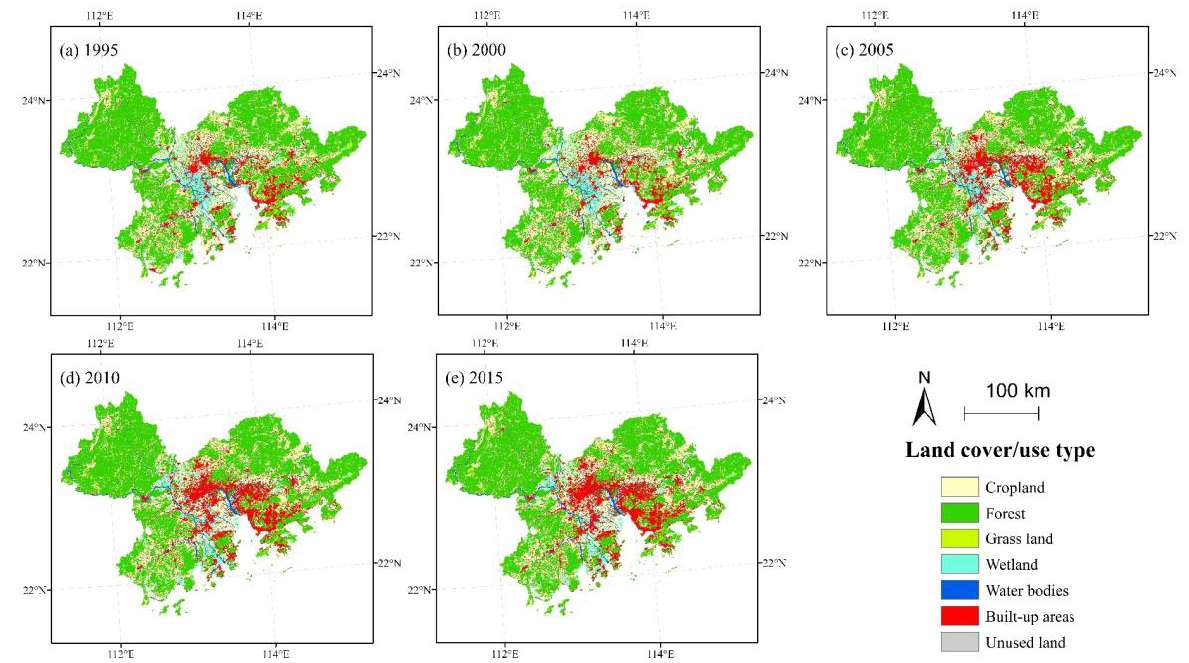
Figure 2. Land cover/use in the GBA during the period from 1995 to 2015: ( a ) 1995, ( b ) 2000, ( c ) 2005, ( d ) 2010, ( e ) 2015. Vector datasets of the road network, residential areas and industrial areas, were obtained from OpenStreetMap (OSM; https://download.geofabrik.de/, accessed on 12 July 2020). We selected road network datasets with railways, primary roads, trunk roads and secondary roads from the attribution of the road layer (fclass) in OSM data. Industry and residential datasets were extracted from the attribution of the land use layer in OSM data. The vector datasets are shown in Figure 3.